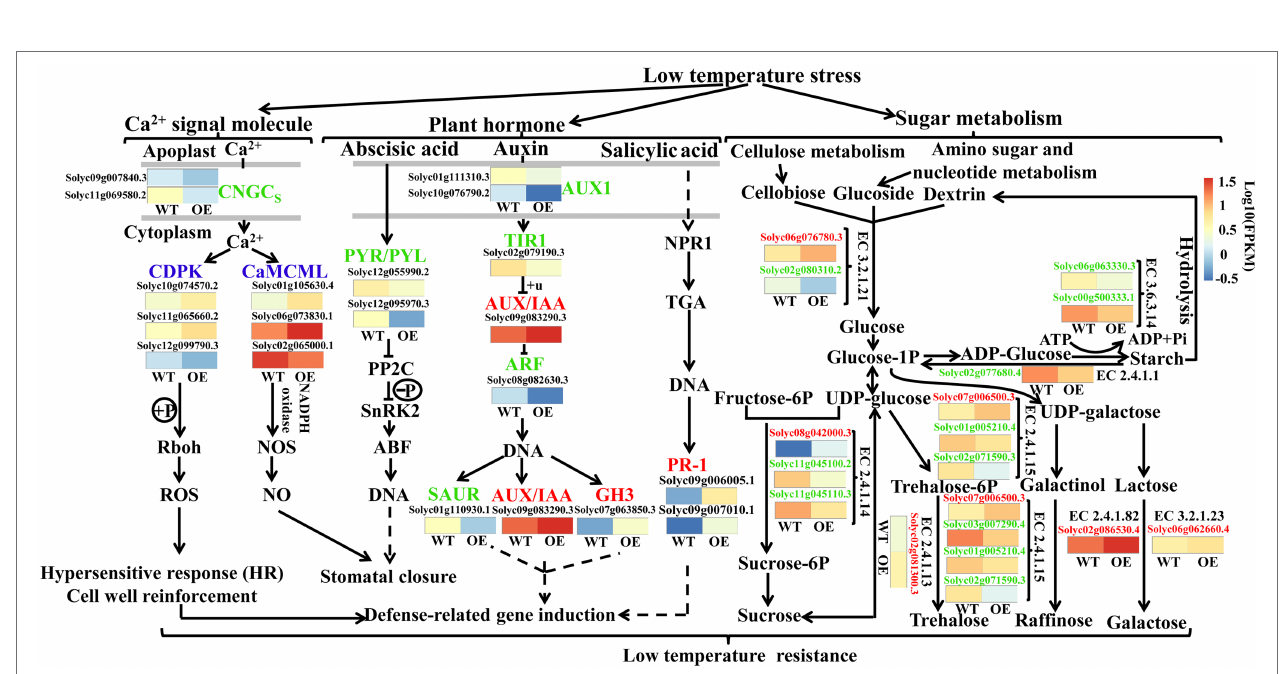
FIGURE 7 | Analysis of differentially expressed genes (DEGs) and KEGG annotation information. (A) The amount of DEGs in OEs after LT stress for 24 h. (B) Cluster and heat map analysis of total up-regulated DEGs. (C) Cluster and heat map analysis of total down-regulated DEGs. (D) The top 20 KEGG pathways were annotated in OEs after LT stress for 24 h. The different color boxes represent the enrichment significance level ( p < 0.05).